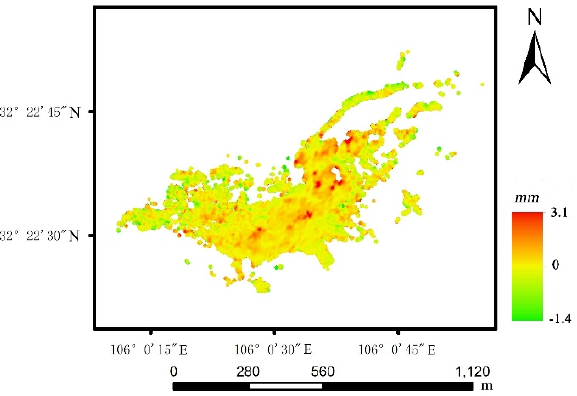
Figure 11. 10/29 20:29 Residual plot of real value and predicted value. Figure 12. 10/29 20:29 residual histogram.